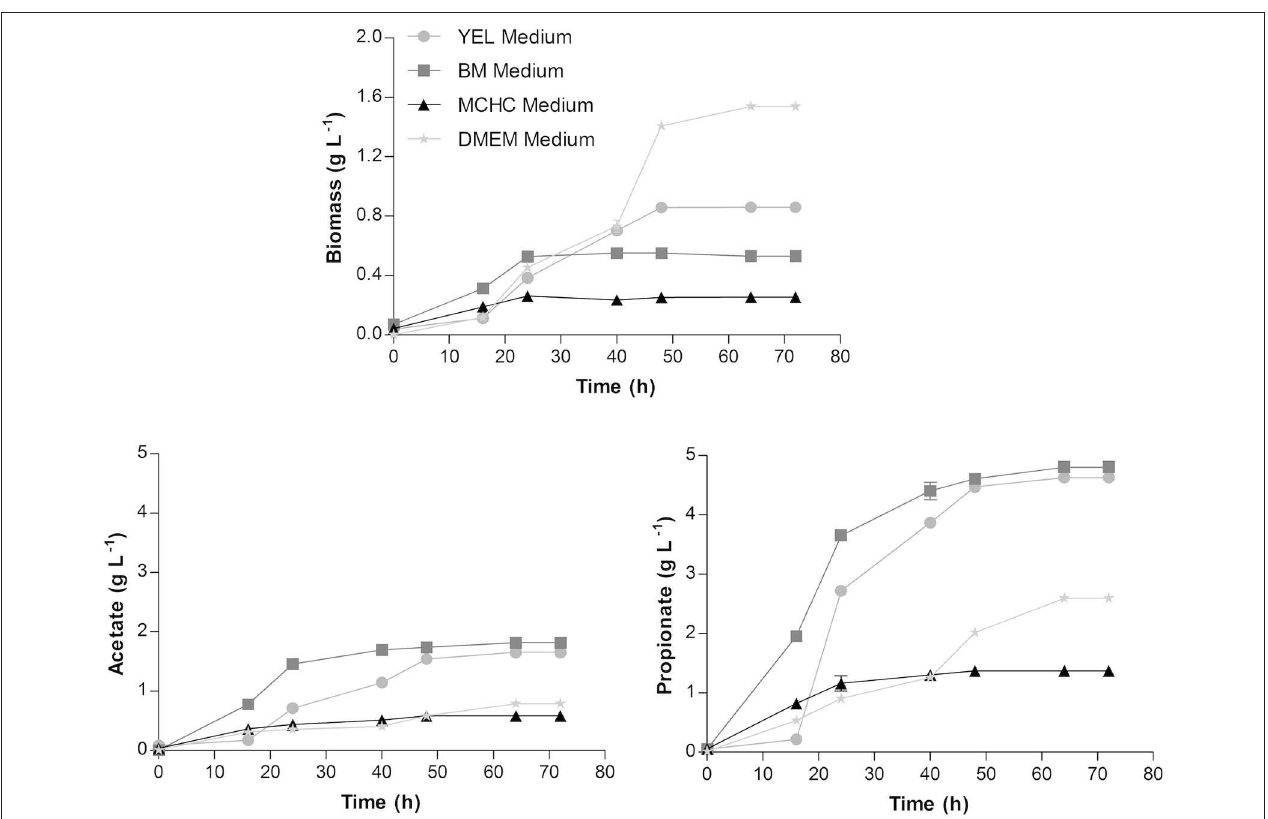
FIGURE 1 | Biomass, acetate and propionate production profiles by Propionibacterium freudenreichii in YEL, BM, MCHC, and DMEM media, at 37 ◦ C. Each condition was run in triplicate and the results correspond to the mean ± standard error of the mean.